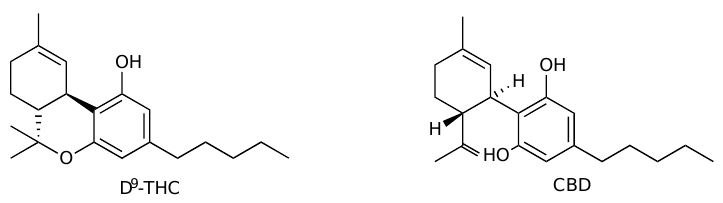
Figure 2. Chemical structures of Δ 9 -THC and CBD.